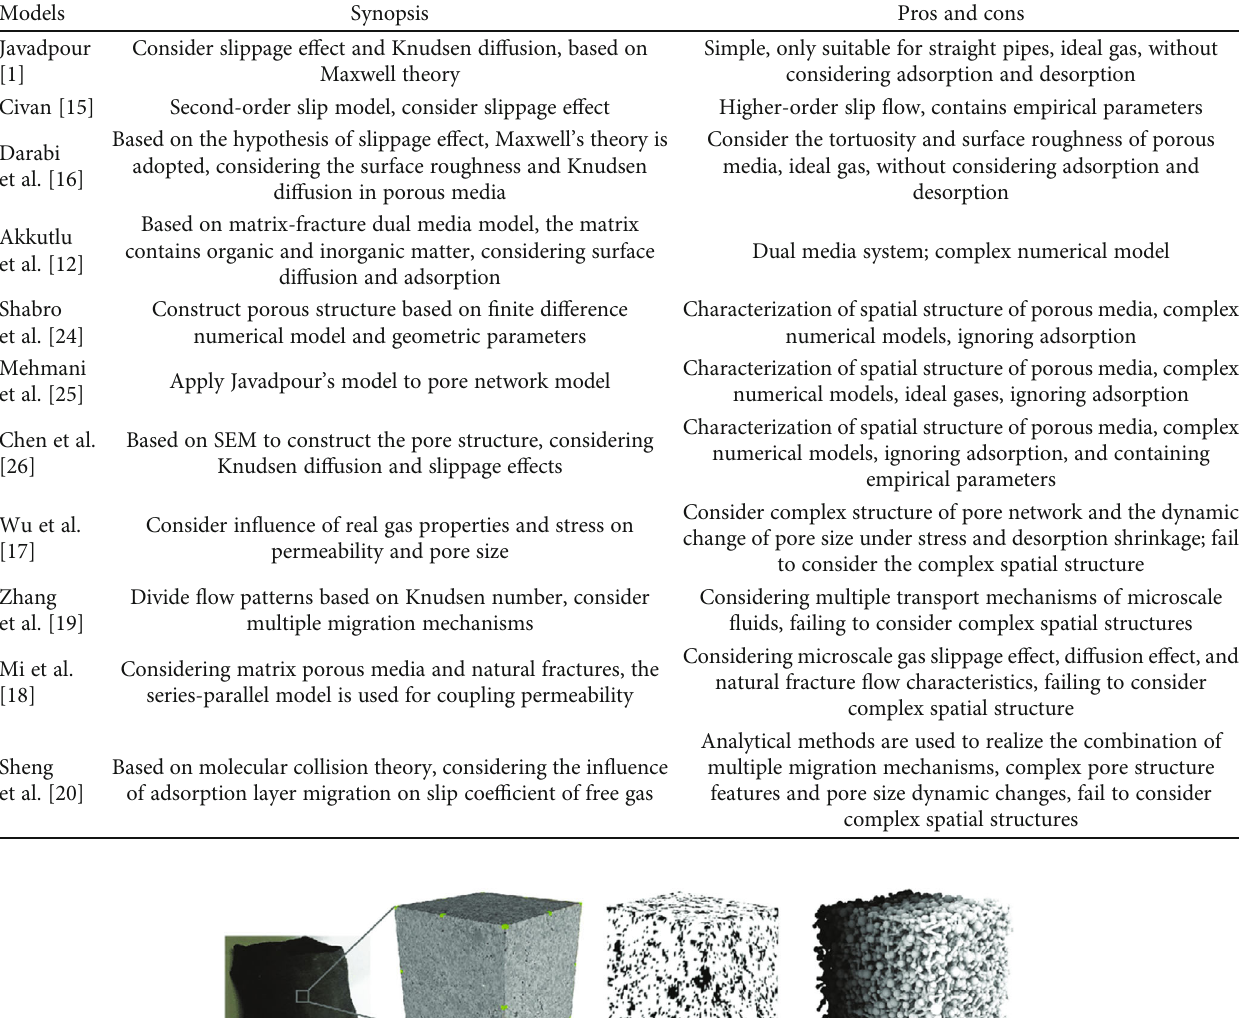
Table 1: Apparent permeability model for shale gas reservoirs.